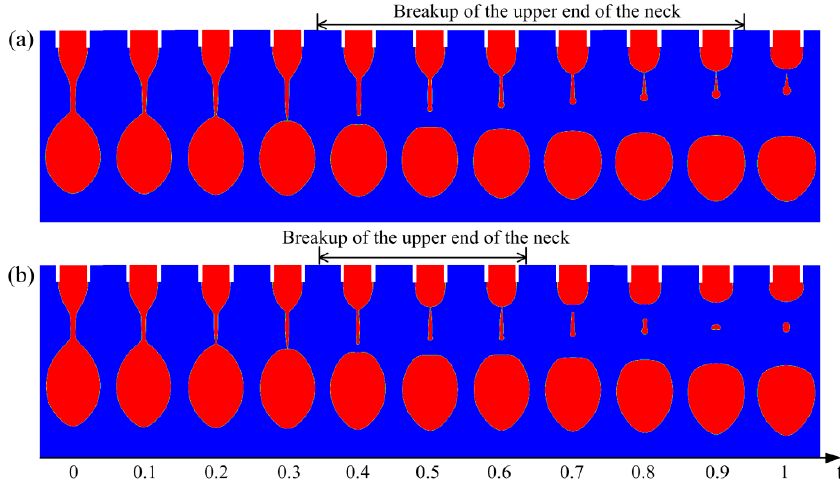
Figure 4. The evolution in time of the drop shape for liquids with CRTs of ( a ) 𝑡 (cid:3032) (cid:3404) 2.5 and ( b ) 𝑡 (cid:3032) (cid:3404) 0.333 . The other parameters of the liquids are 𝜀 (cid:3045) (cid:3404) 50 , 𝑂ℎ (cid:3404) 0.05 , ɸ (cid:3404) 6 , 𝑄 (cid:3046) (cid:3404) 0.314 .